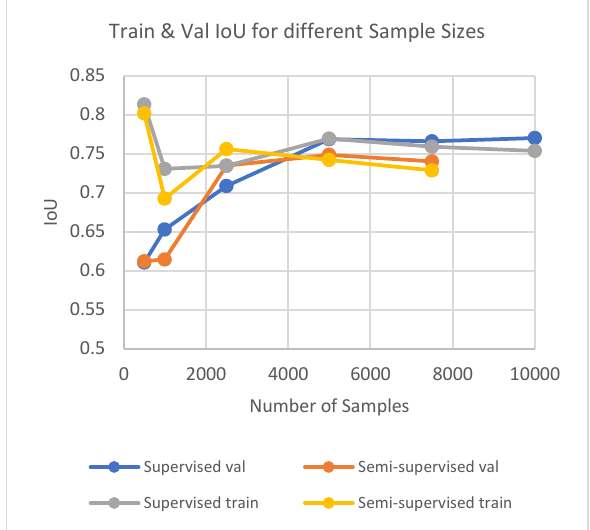
Figure 3 . Training and validation IoU metrics for semi- supervised and supervised models for varying number of labelled training